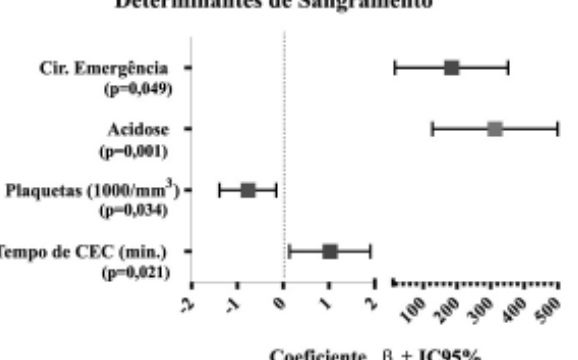
Fig. 1 – Fatores de risco determinantes de sangramento através de análise multivariada. O eixo Y representa as diversas variáveis com os seus respectivos valores de p. O eixo X representa o coeficiente ß com intervalos de confiança de